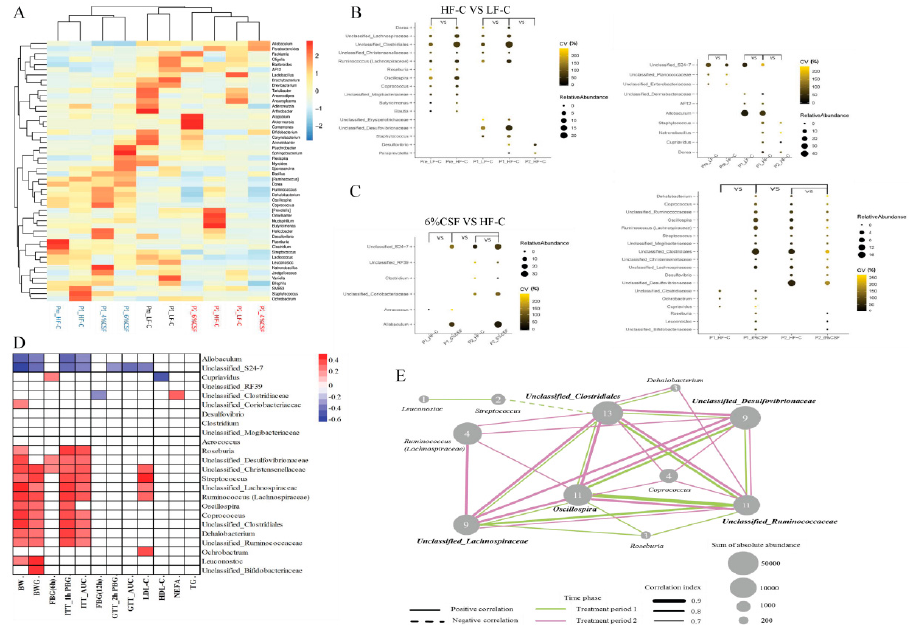
Figure 6. Microbial taxonomy and interaction of CSF on fecal microbiota over time. ( A ) Clustering of the dental plaque microbiota at the genus level. ( B ) Significantly differential genera in HFD relative to LFD-fed mice. ( C ) Significantly differential genera at each time point in 6% CSF group with the horizontal and longitudinal comparisons by Metastats analysis. The sizes and colors of the circles indicate the average abundance and the coefficient of variance (CV) of the abundance, respectively. ( D ) Correlation of differential genera with obesity and glycolipid metabolism. BW—body weight; BWG—body weight gain; FBG(6